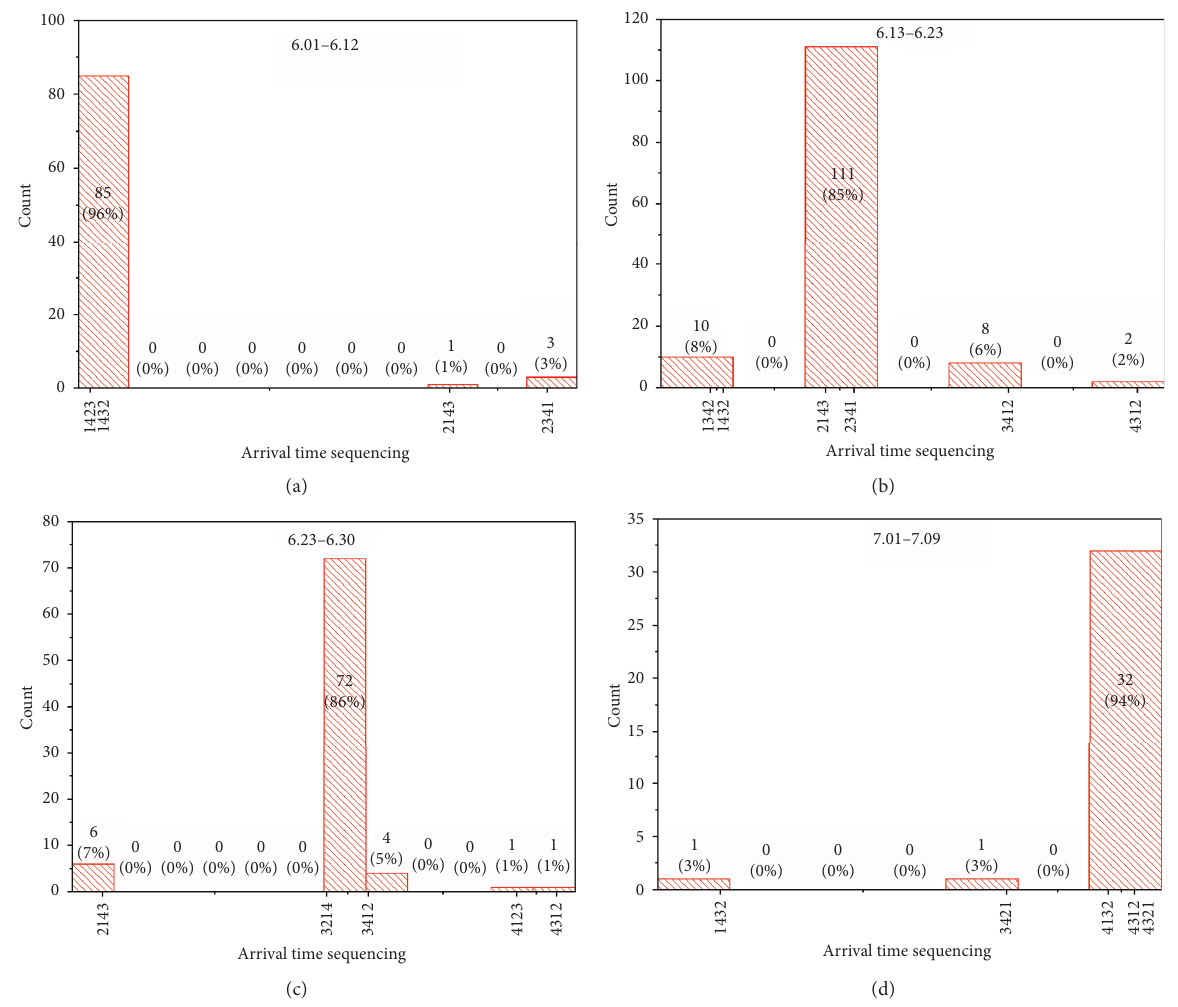
Figure 10: Statistical results of the proportion of arrival time sequencing in different periods.